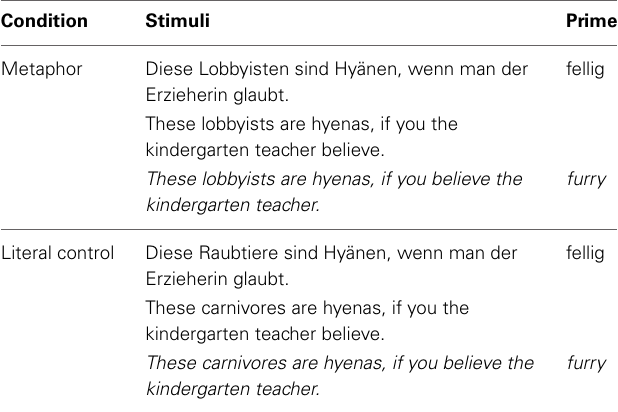
Table 2 | Example of critical stimuli for Experiment 1a and 1b.